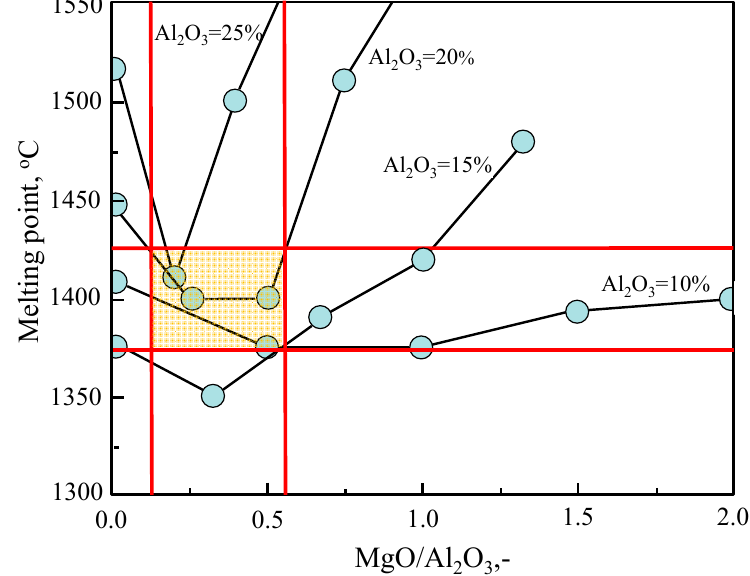
Figure 7. Correlation of the MgO/Al 2 O 3 ratio and melting point for slag containing different contents of Al 2 O 3 [1].